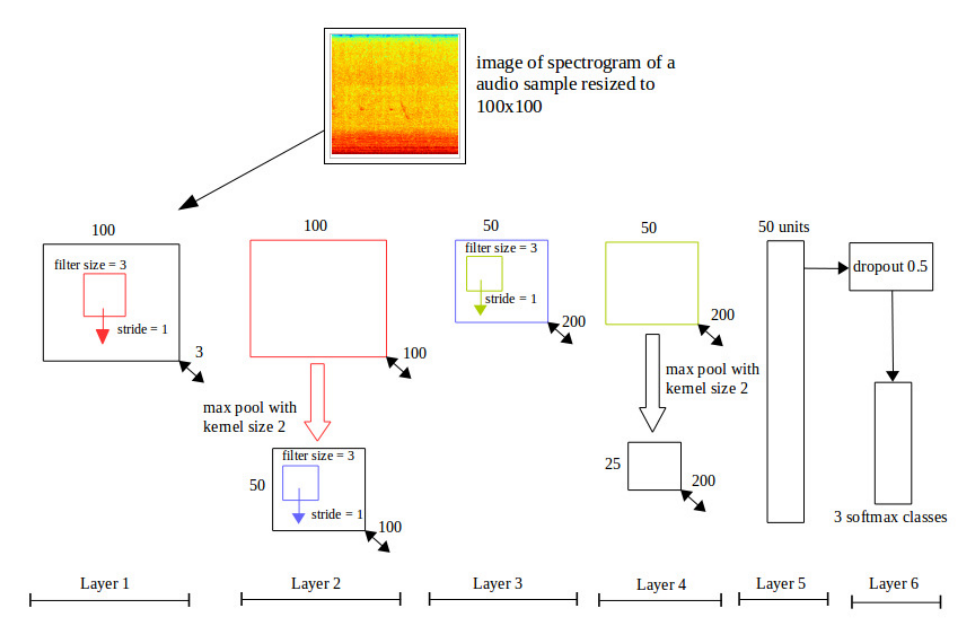
Figure 6. SpectConvNet Control Flow. Layer by layer control flow of SpectConvNet; the numbers at the corners of each rectangle represent the corresponding